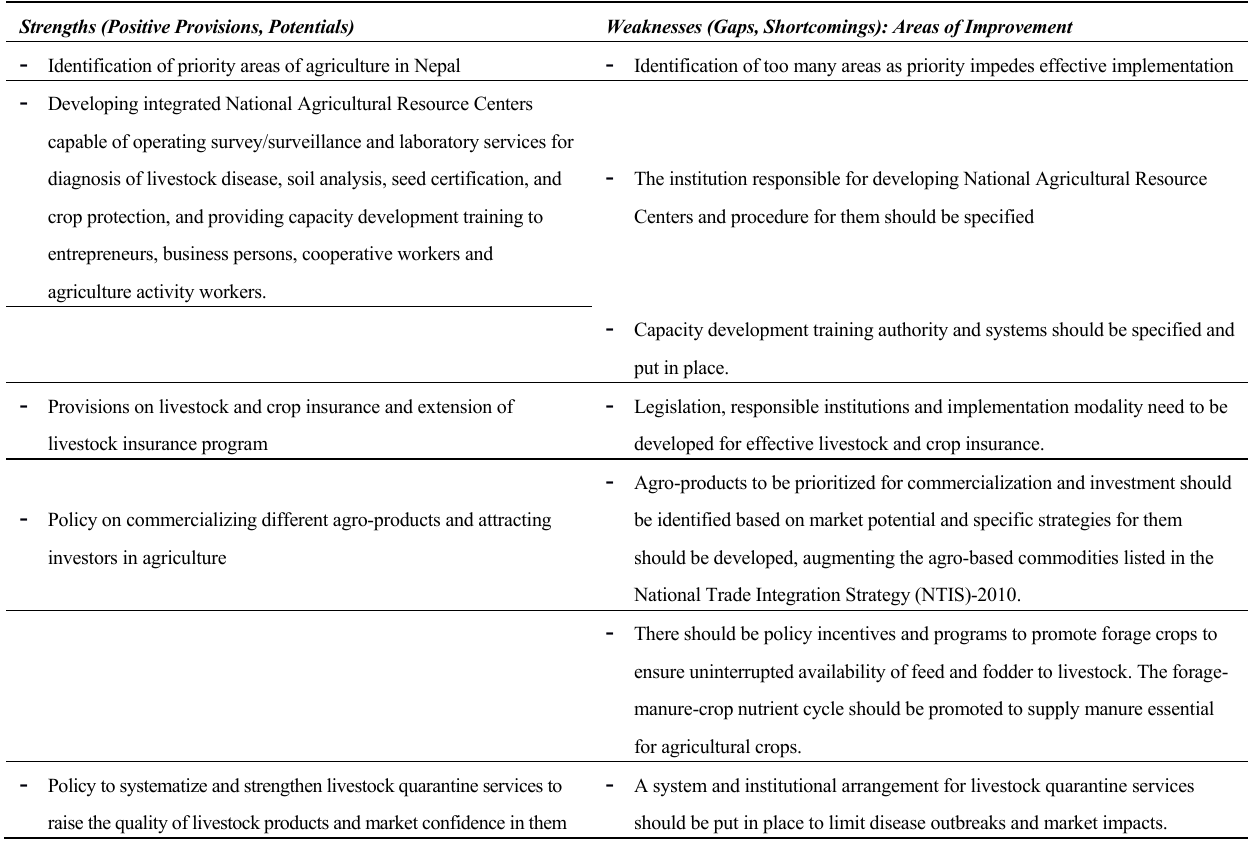
Table 2. Outcomes of SWOT analysis of National Agricultural